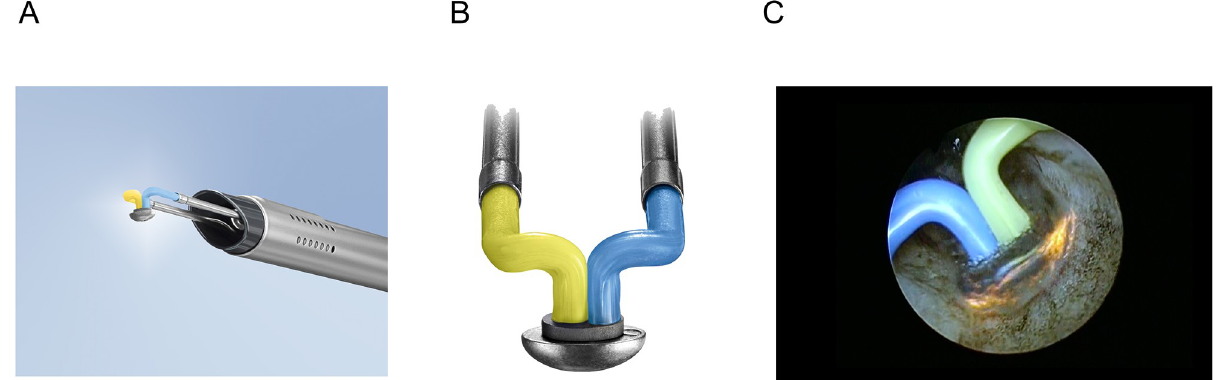
Fig 1. Image of the second-generation B-TUVP with oval electrode (A, Olympus, Tokyo) and zoomed image of the oval electrode (B) (Both images were kindly provided with request for citation by Olympus, Tokyo).Image of vaporization of prostate with the oval electrode in second-generation B- TUVP